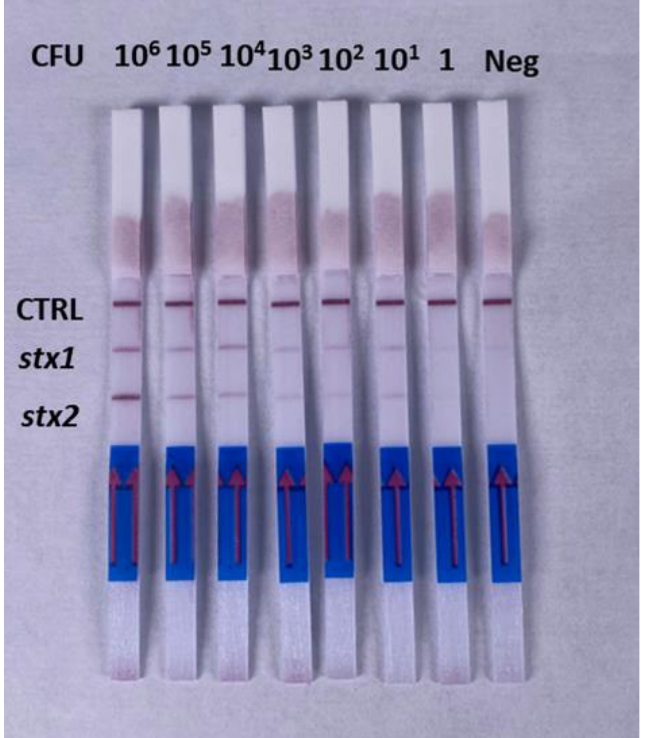
Figure 5. LOD determination in media. Genomic DNA of E. coli O157:H7 was harvested from varying concentrations of bacteria ranging from 10 6 to 1 CFU/mL with a negative control as lysis buffer. Results were repeated in at least three separate experiments with a representative set being shown.